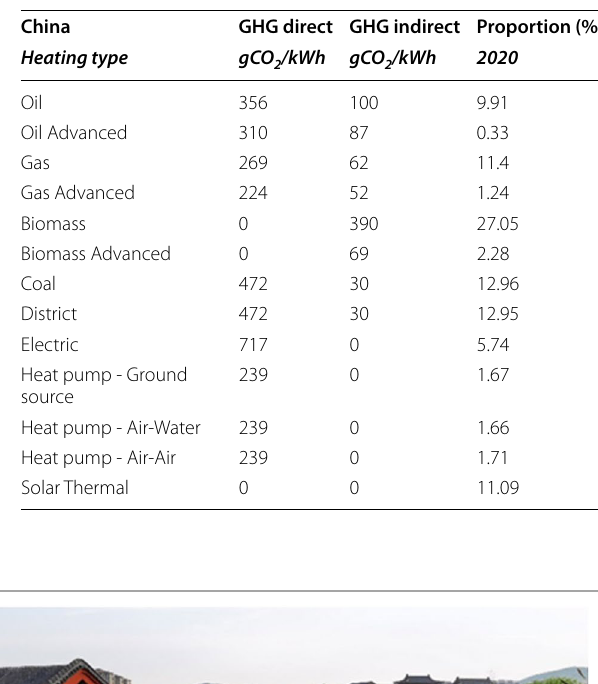
Table 3 GHG emission intensities and market shares of different heating technologies in